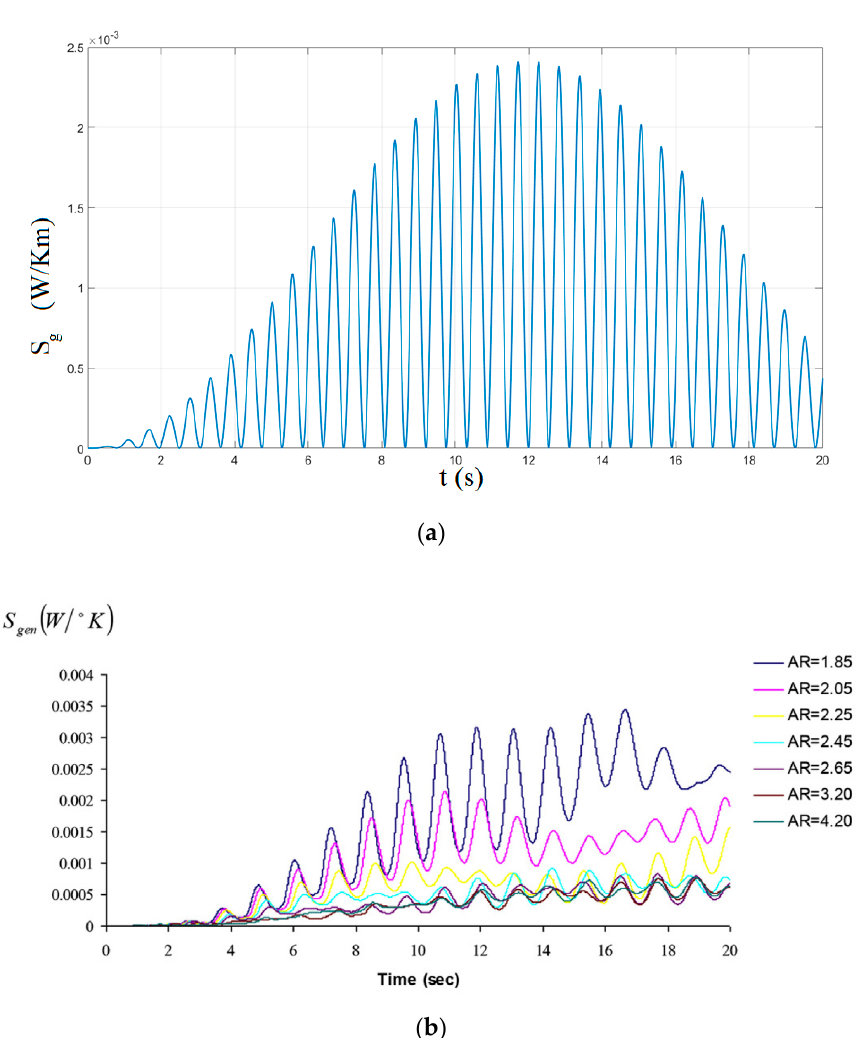
Figure 4. Entropy generation versus time for α = 2.05 ( a ) current study, ( b ) Reference [1].